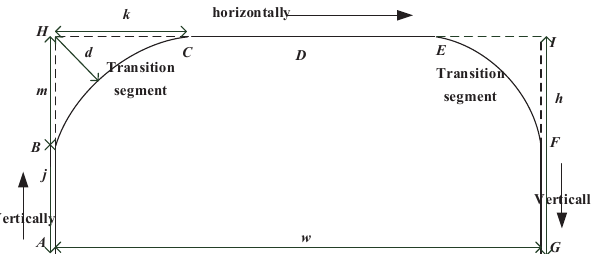
Figure 2. Geometric path for pick-and-place operation